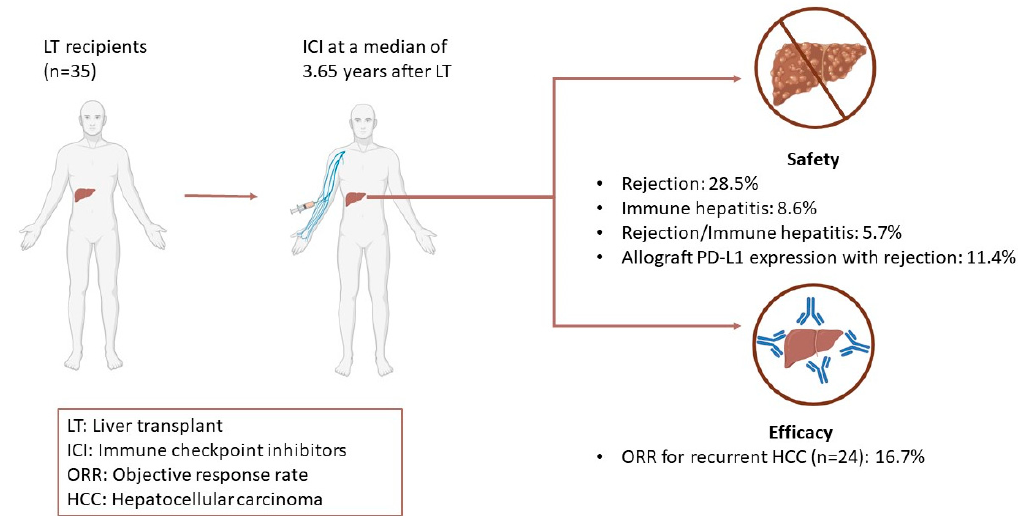
Figure 1. Efficacy and Safety Outcomes of Adjuvant Immunotherapy after Liver Transplant.